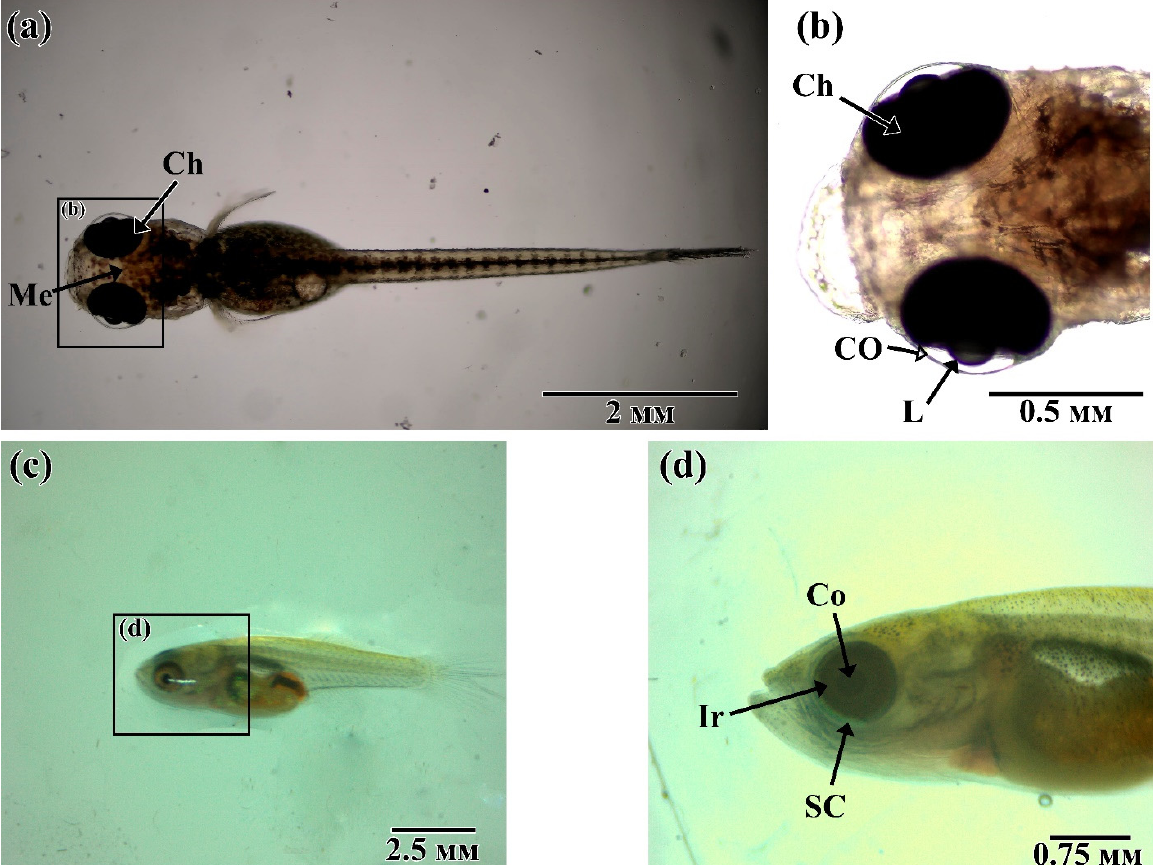
Figure 3. Postembryonic development of the visual system of N. guentheri: ( a , b ) 5 to 10 hph larva; ( c , d )—7 dph larva. Ch—choroid; Me—melanophores; L—lens; C о —cornea, Ir—iris.